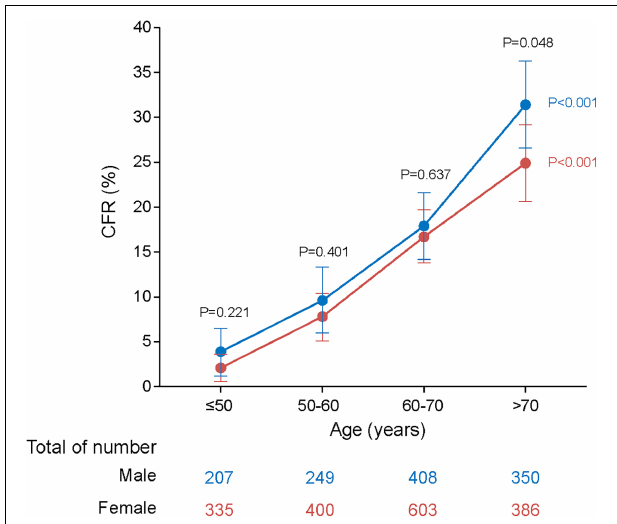
FIGURE 1 | Dynamic profiles of CFRs for males and females across age stratifications in SFTS patients. P values were calculated by Chi-square tests. The blue line represents CFRs of males across age stratifications and the red line represents CFRs of females across age stratifications. The error bars indicate 95% CIs. The numbers of males and females across age stratifications were listed on the below. Four age stratifications were classified based on case number: ≤ 50, 50–60, 60–70, and > 70 years. The P values colored with blue represent statistical difference among age groups in males. The P values colored with red represent statistical difference among age groups in females. The P values colored with black represent statistical difference based on age stratification for both male and female patients. As evident from the plot, CFRs rise with increasing age and males are more likely to be affected by